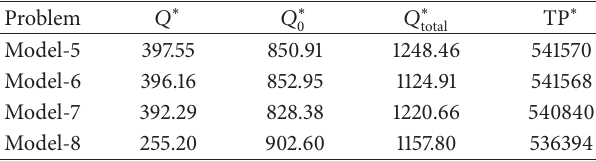
Table 7: The optimal results of the bifuzzy models.